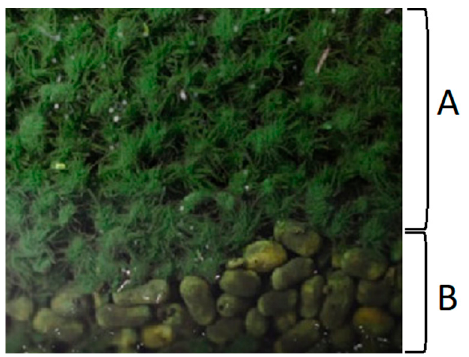
Figure 5. Two morphologies of OPGs: A—dreadlock-like and B—bald granules [23].